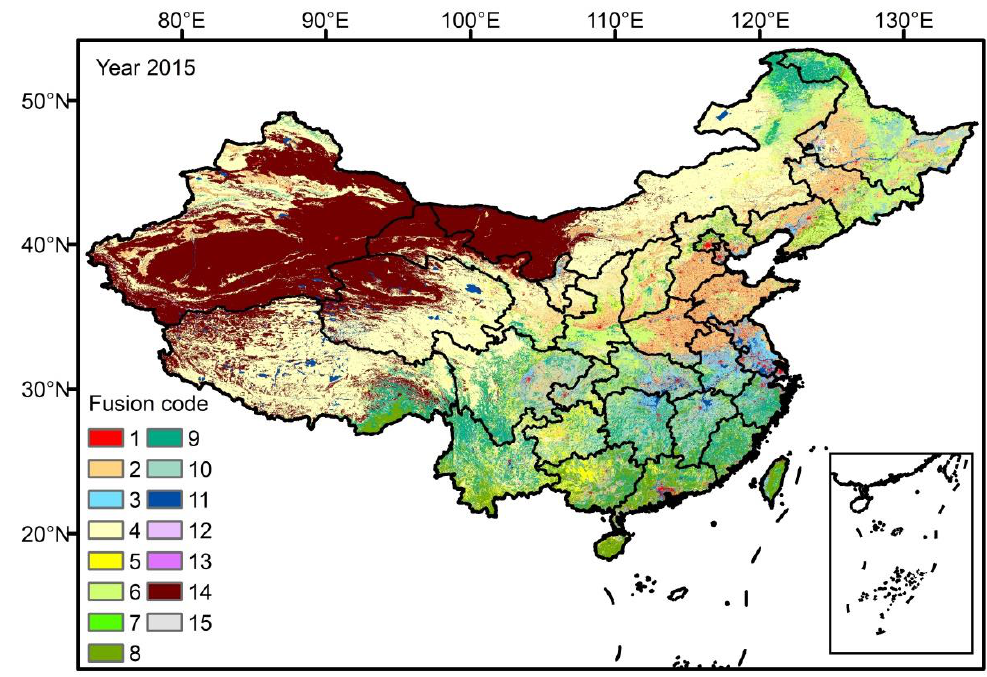
Figure 3. China fusion land cover data in 2015 for Noah-MP LSM.